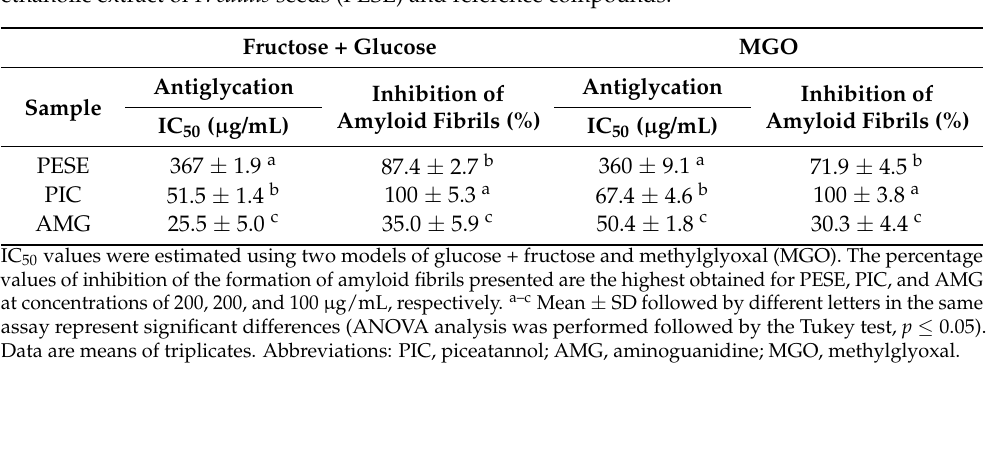
Table 2. The antiglycation activity and percentage of inhibition of formation of amyloid fibrils of ethanolic extract of P. edulis seeds (PESE) and reference